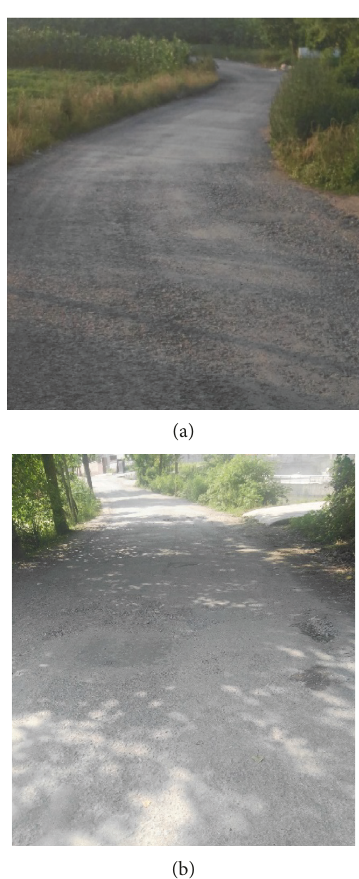
Figure 21: Cement-treated (a) and lime-treated (b) test sections after 10-year traffic.